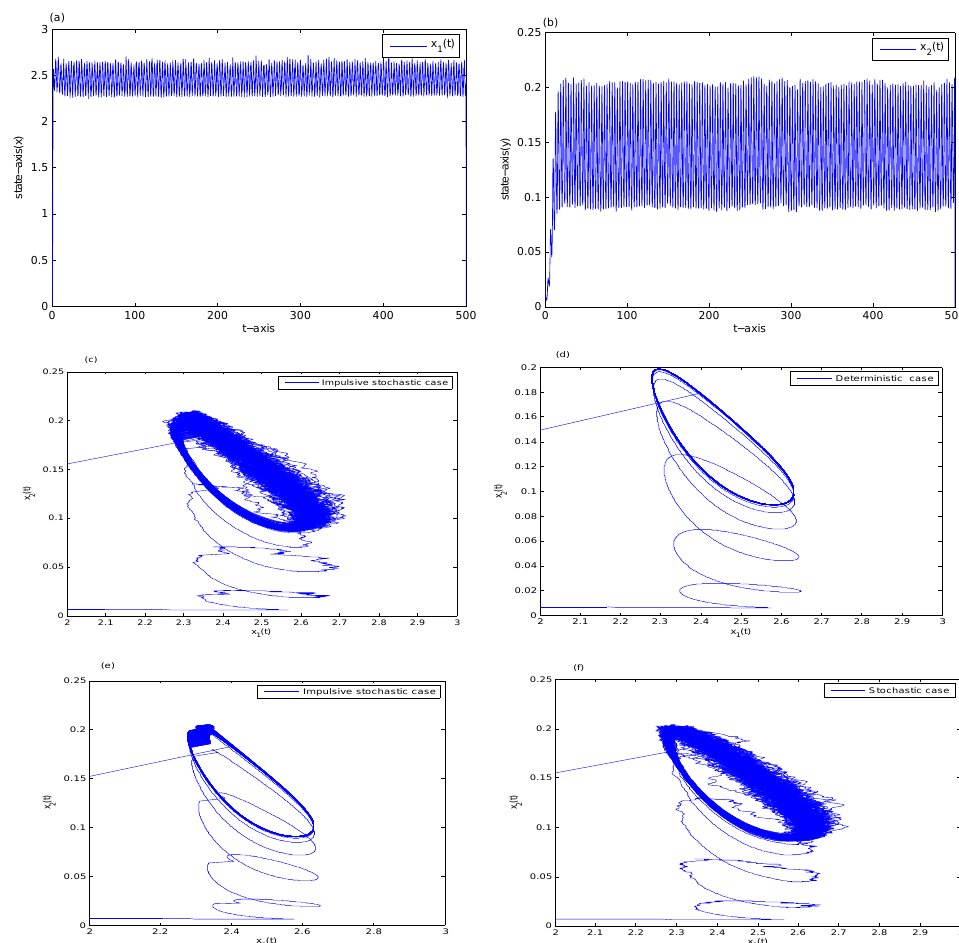
Figure 1. The periodic Markovian process for (2) with initial data x 1 ( 0 ) = x 2 ( 0 ) = 0.02. ( a ) The time series graph of x 1 ( t ) for Example 1; ( b ) the time series graph of x 2 ( t ) for Example 1; ( c ) the phase graph of Example 1 with σ i ( t ) (cid:54) = 0, ξ ik (cid:54) = 0; ( d ) the phase graph of deterministic system ( ξ = σ ( t ) = 0 ) ; ( e ) the phase graph of impulsive system ( σ i ik stochastic system ( σ i ( t ) (cid:54) = 0, ξ ik = 0 ) i = 1,2, k ∈ N . Similarly, we can verify that all parameters meet (H 2 ) and Theorem 3 shows that the solution of (2) is globally attractive. Figure 2 confirms this.